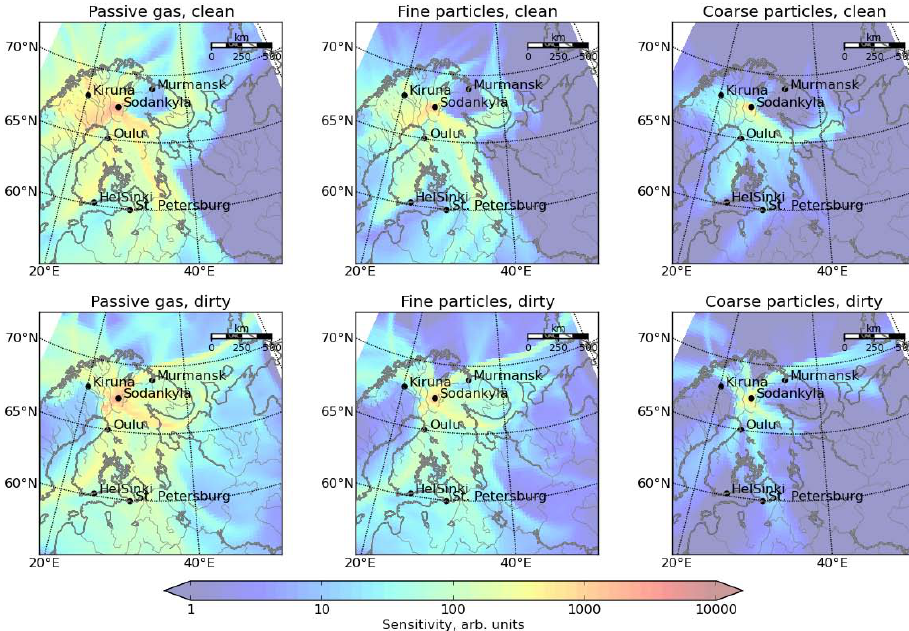
Fig. 9. The footprints for “clean” (upper panels) and “dirty” snowfall (lower panels), on the basis of measured BC mixing ratio in surface- snow samples, for (i) passive gas (no deposition, decay, etc., left), (ii) fine aerosol (middle), and (iii) coarse aerosol